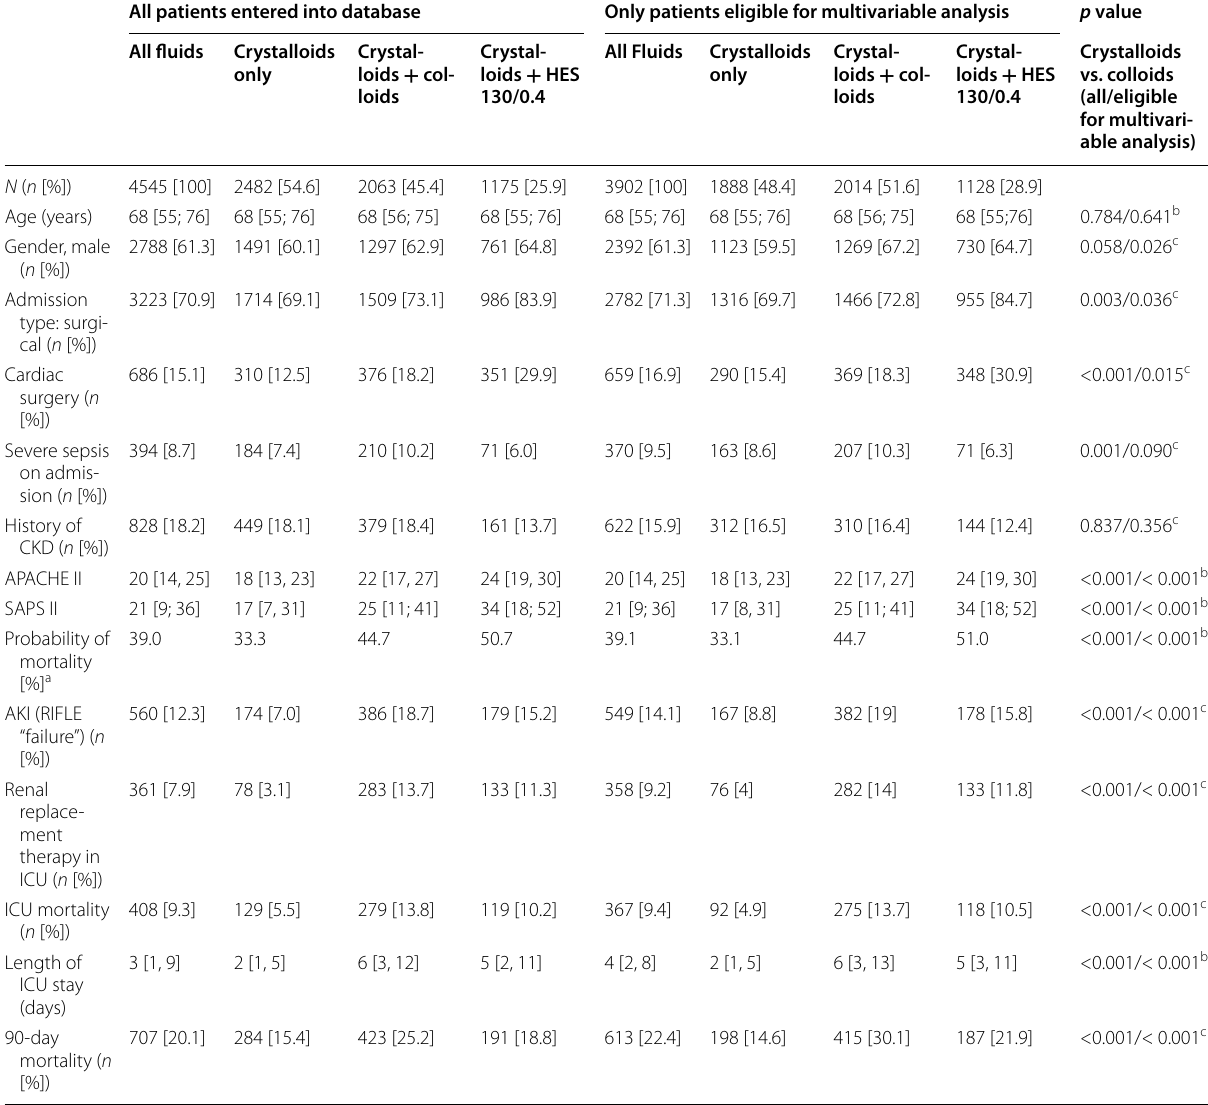
Table 1 Baseline characteristics of study patients and